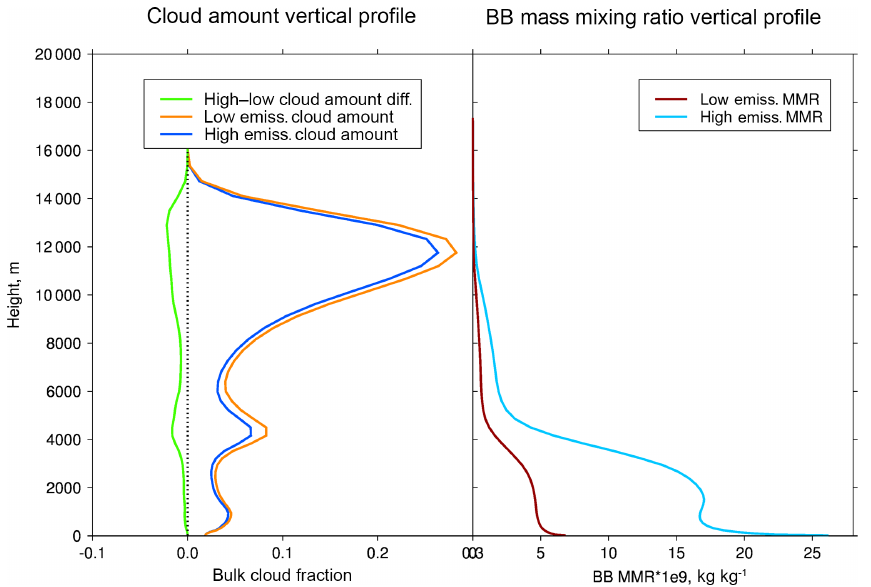
Figure 7. September mean vertical profile of cloud fraction for high emissions, low emissions, H − L compared with the vertical profile of the aerosol burden mass mixing ratio (MMR) in kilograms per kilogram (kgkg − 1 ) (both quantities averaged over BB box area outlined in area